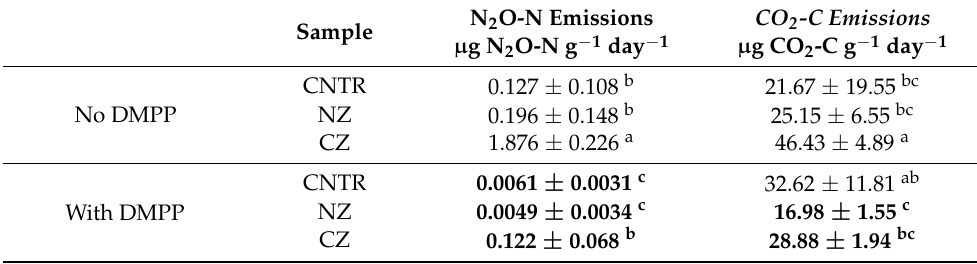
Table 4. N 2 O-N and CO 2 -C emission rates throughout incubation. Values are expressed as mean ± standard deviation (4 replicates). Different superscript letters express significant differences as a result of ANOVA (for N 2 O-N, ln transformed), Kruskal-Wallis (for CO 2 -C), and Tukey-HSD statistical tests ( p < 0.05). Values in bold highlight a significant effect of